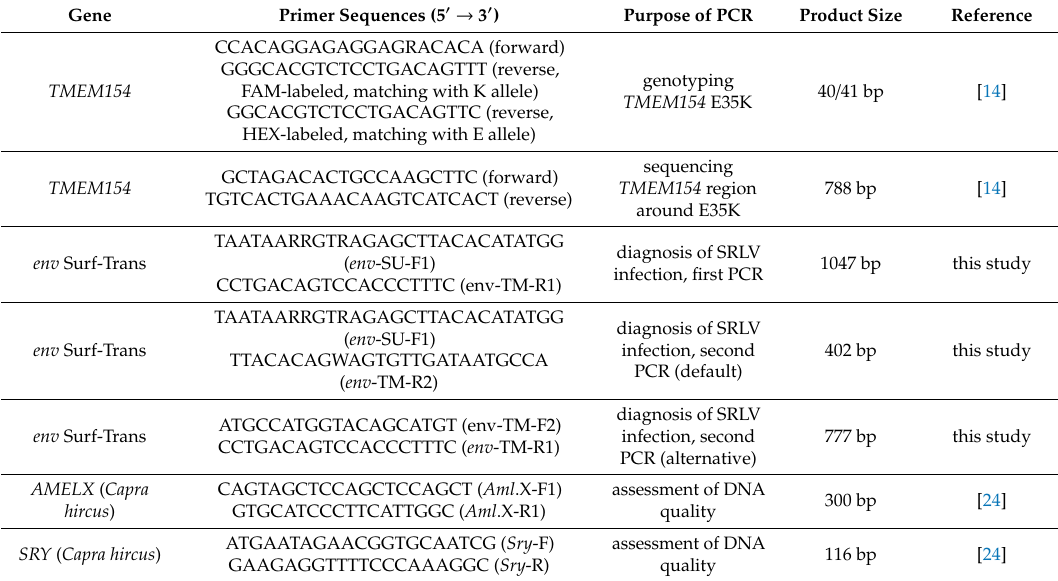
Table A2. Details on PCR amplifications done in this study.